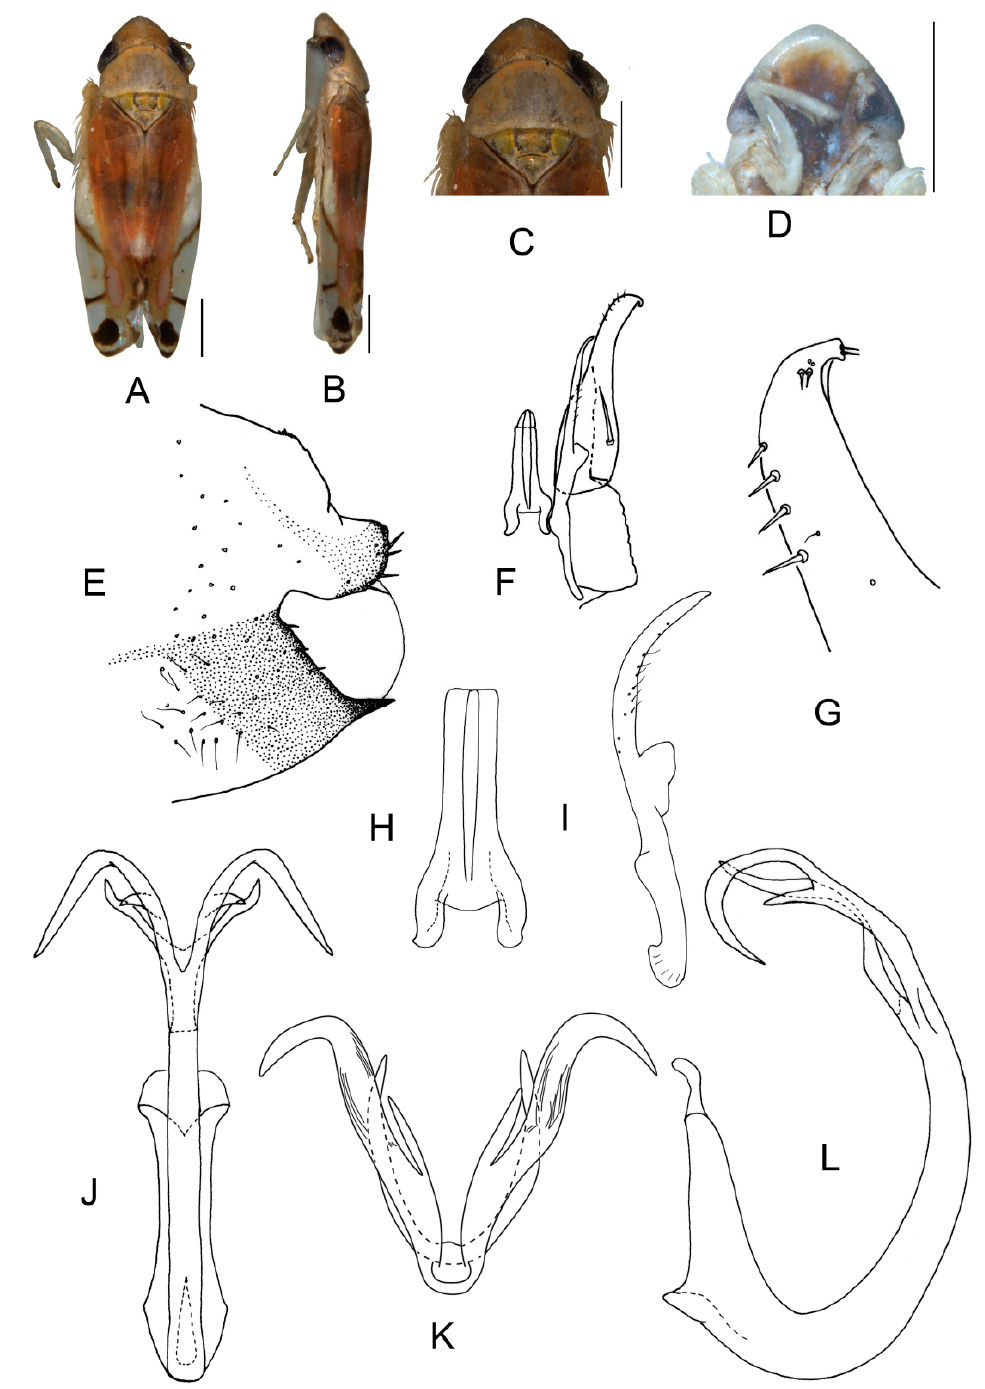
Figure 7. Eurhadina ( Singhardina ) scamba sp. nov. : ( A ) habitus, dorsal view; ( B ) habitus, lateral view; ( C ) head and thorax, dorsal view; ( D ) face; ( E ) hind part of pygofer, lateral view; ( F ) subgenital plate, connective, paramere and sternite IX, dorsal view; ( G ) apex of subgenital plate, dorsal view; ( H ) connective, dorsal view; ( I ) paramere, dorsal view; ( J ) aedeagus, posterior view; ( K ) apex of aedeagal shaft, dorsal view; and ( L ) aedeagus, lateral view. Scale bars: 0.5 mm. Eurhadina ( Singhardina ) scandens Zhang et Huang sp. nov. (Figure 8A–M)